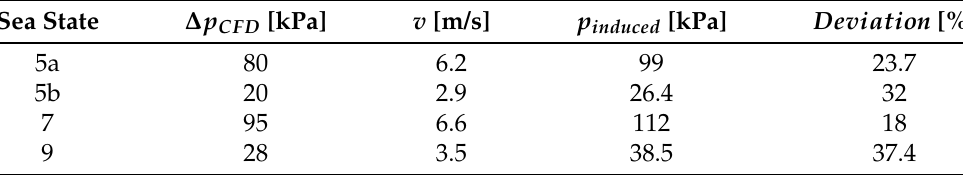
Table 6. Induced-pressure on the buoy due to the short impact of the wave–structure interaction as it is given from CFD simulations, ∆ p CFD , and, as calculated from the Equation (25), p induced . The relative velocity, v , as calculated from the CFD simulations, is also given. The deviation between the theoretical and the numerical pressure is